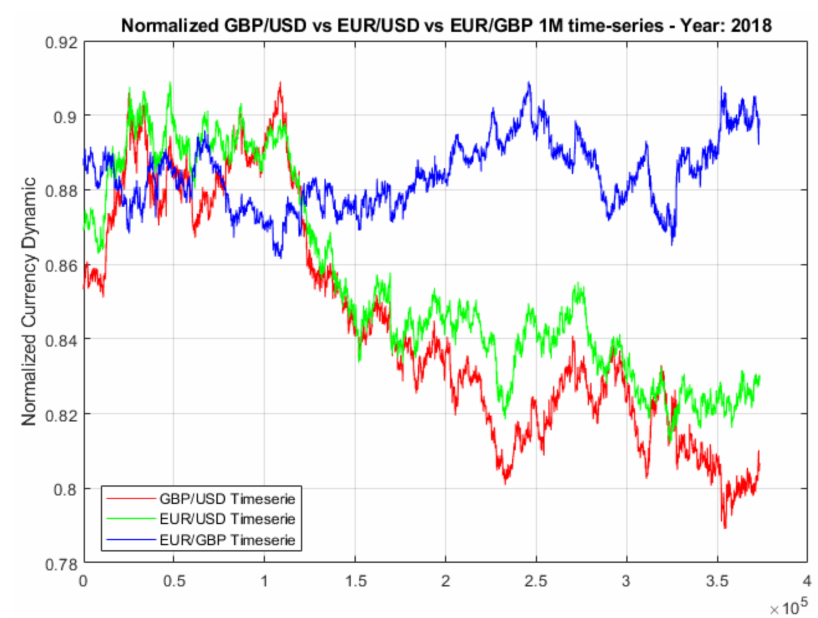
Figure 3. The normalized EUR / USD, GBP / USD, EUR / GBP close price time-series (for year